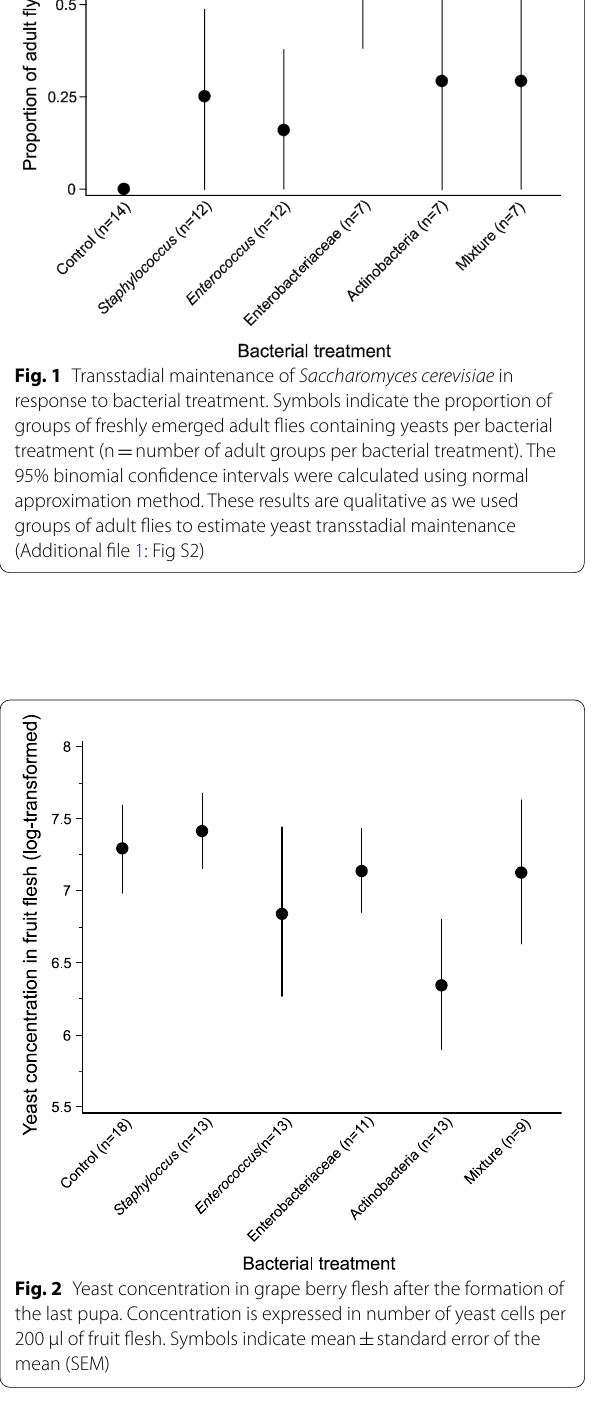
standard error of the ±